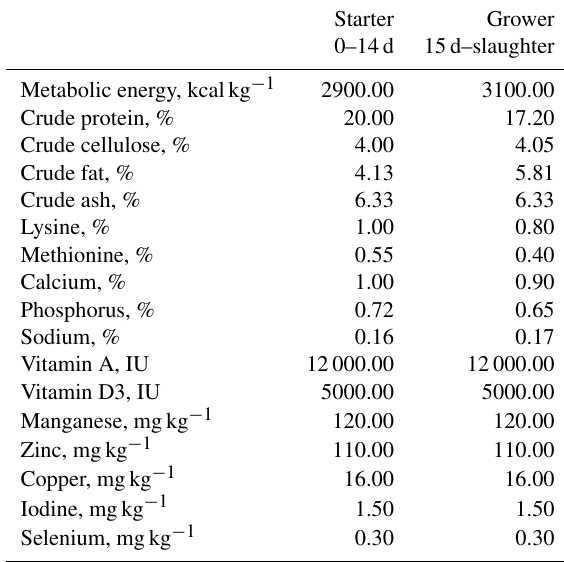
Table 1. Nutritive value of the feed used in the